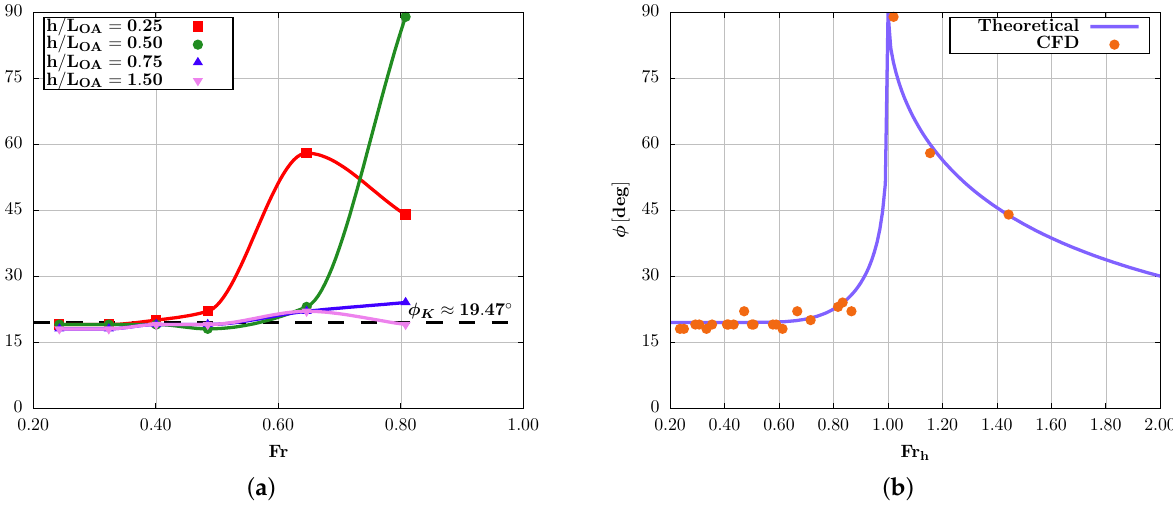
Figure 12. The effect of advance speed and water depth on half wake angle ( φ ); ( a ) Half wake angle versus Fr , ( b ) Half wake angle versus Fr h . CFD based wake angles determined are compared in ( a ) with theoretical φ K 19.47 ◦ , deep water, result for low values of Fr [58] and in ( b ) with Havelock’s ≈ (1908) theoretical results [59].